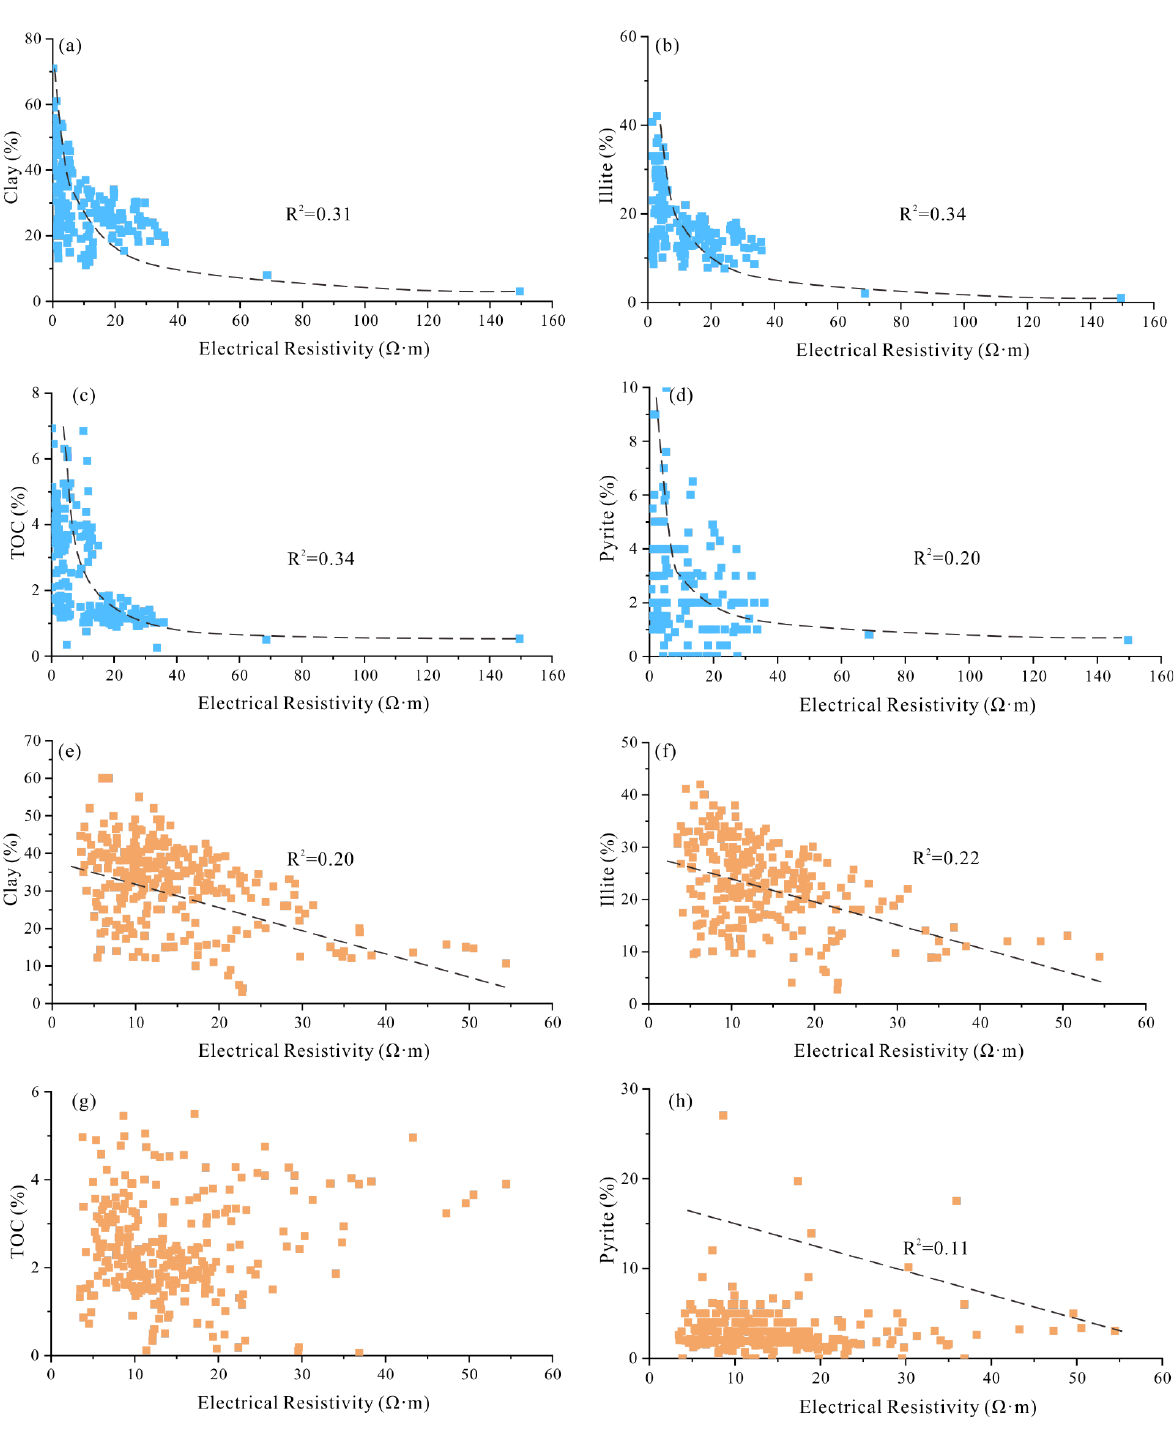
Figure 8. Relations between sedimentary element and electrical resistivity, ( a ) clay content versus electrical resistivity at the Changning block, ( b ) illite content versus electrical resistivity at the Changning block, ( c ) TOC versus electrical resistivity at the Changning block, ( d ) pyrite content versus electrical resistivity at the Changning block, ( e ) clay mineral content versus electrical resistivity at the Luzhou block, ( f ) illite content versus electrical resistivity at the Luzhou block, ( g ) TOC versus electrical resistivity at the Luzhou block, ( h ) pyrite content versus electrical resistivity at the Luzhou